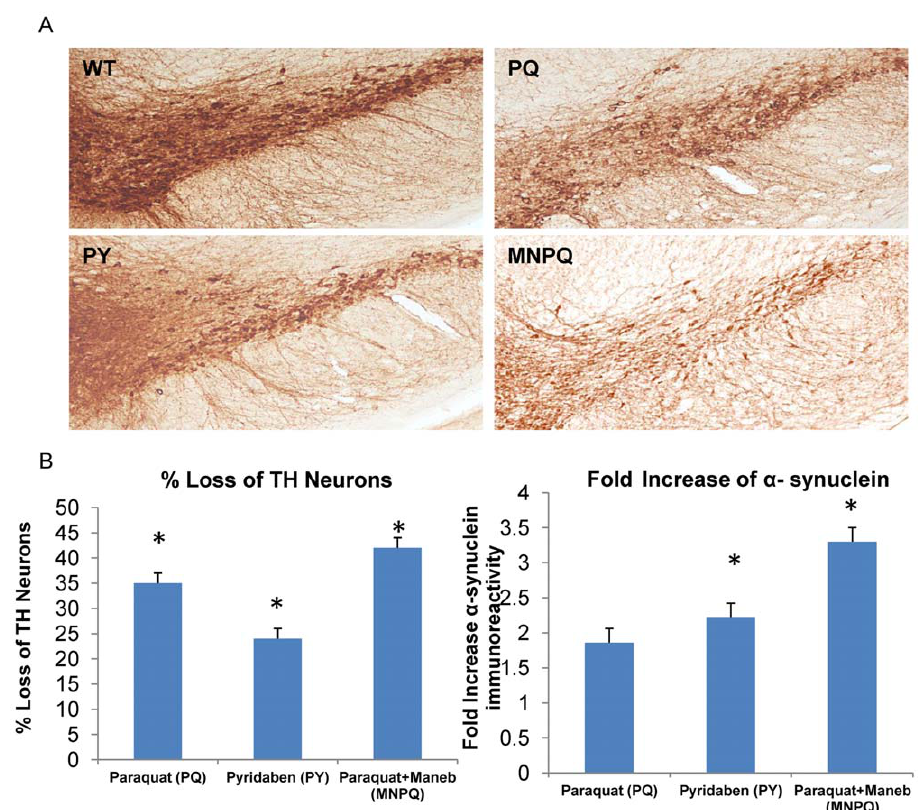
Figure 1. Pesticide induced loss of TH + neurons and increased a -synuclein immunoreactivity. A) Immunostaining of SN of PQ, PY, MNPQ and wild type (WT) mice with tyrosine hydroxylase antibody. B) Percent loss of TH + neurons and fold increase of a -synuclein immunoreactivity compared to wild type control mice.